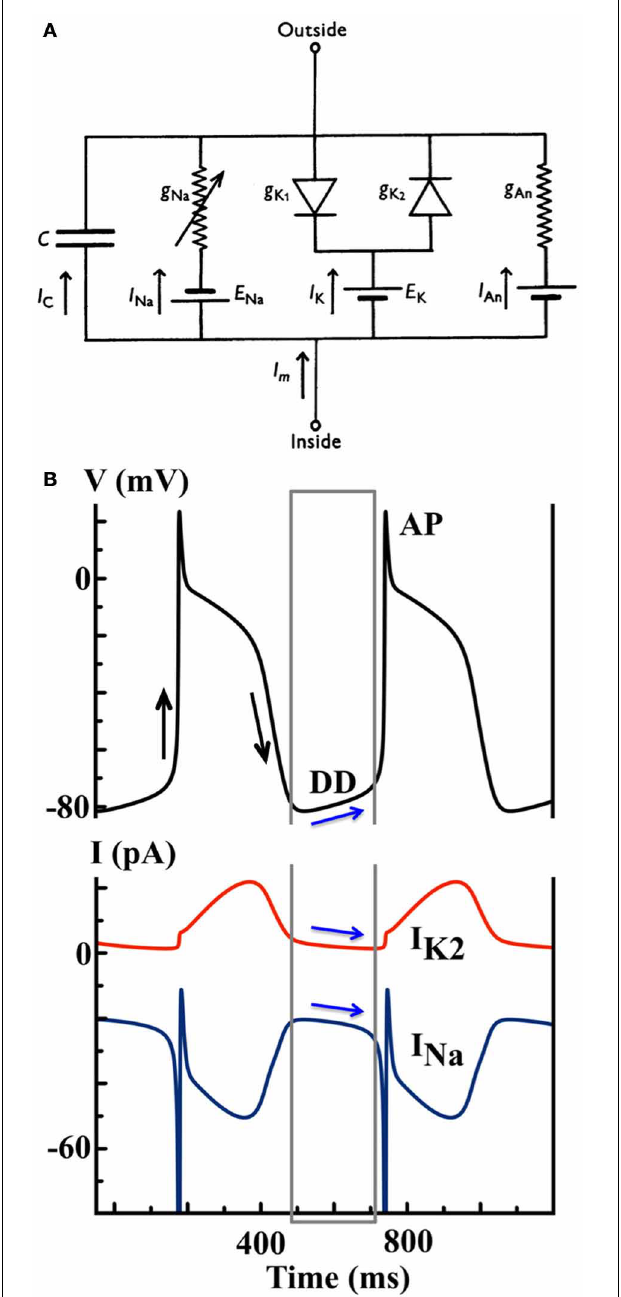
FIGURE 1 | The cardiac conduction system and the cascade of cardiac pacemaking tissues; figure modified from (17). Green arrows indicate the cardiac activation sequence during sinus rhythm. SAN, sinoatrial node; AVN, atrioventricular node; PF, Purkinje fibre; RA, right atrium; LA, left atrium; RV, right ventricle; LV, left ventricle; TV, tricuspid valve; MV, mitral valve.